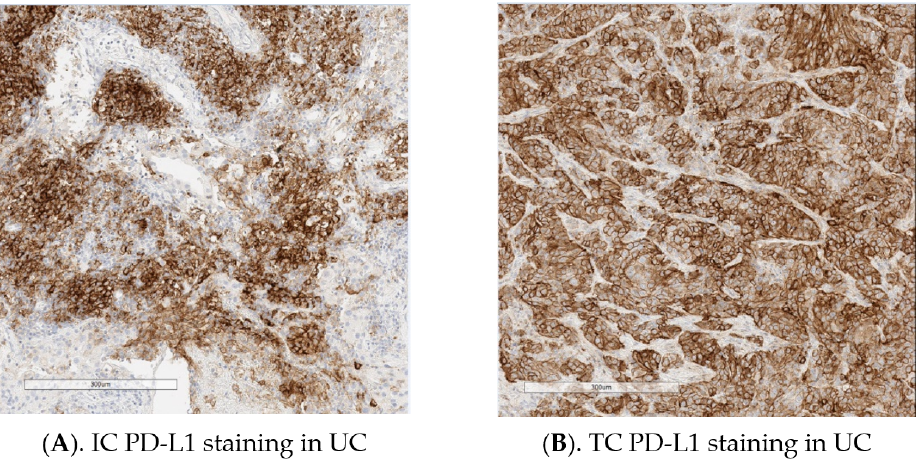
Figure 1. ( A , B ). Examples of immune cell (IC) and tumor cell (TC) programmed cell death-ligand 1 (PD-L1) staining in urothelial carcinoma (UC) using the VENTANA PD-L1 (SP263) Assay (Images provided by Marietta Scott, Precision Medicine & Biosamples, AstraZeneca).